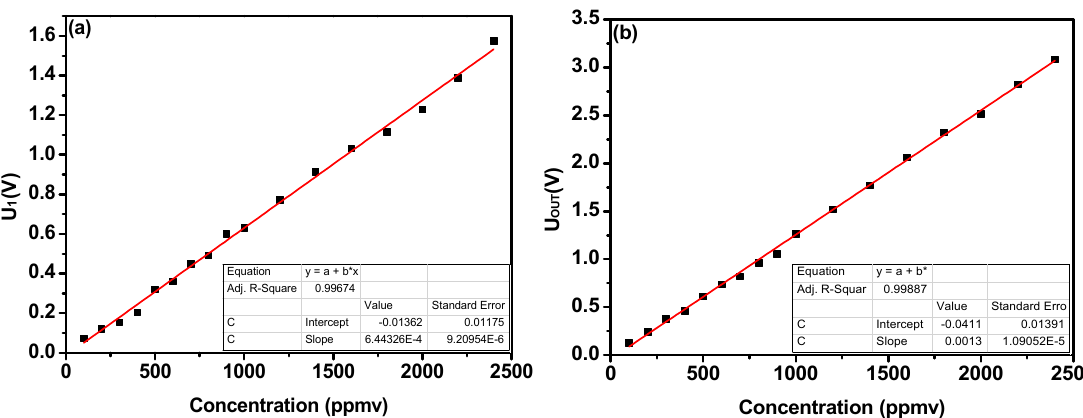
Figure 5. ( a ) Linearity test result with different water vapor concentration using DFB-LD 1 and lock-in amplifier 1, ( b ) Linearity test result with different water vapor concentration using dual path lock-in system.